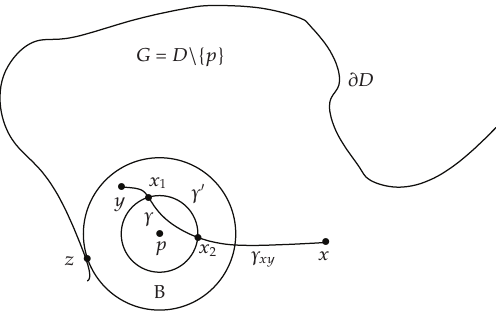
Figure 2: The geodesic path γ xy (cid:5) w.r.t. the Apollonian inner metric (cid:2) α D (cid:6) connecting x and y intersects B , and its modification γ (cid:9) from x 1 to x 2 along the circular